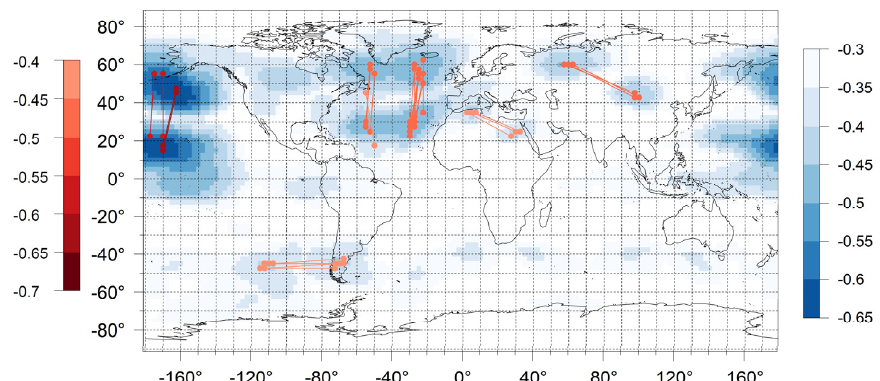
Figure 1. Correlation map of the Z500 field of the NCEP-NCAR R1 for the period of 1991–2019. Strongest negative correlations associated with the grid cells are denoted with blue-shaded dots. Grid cells of each potential action center are denoted with red circles and are connected with red lines. Brighter (darker) colors are associated with weaker (stronger) correlations.